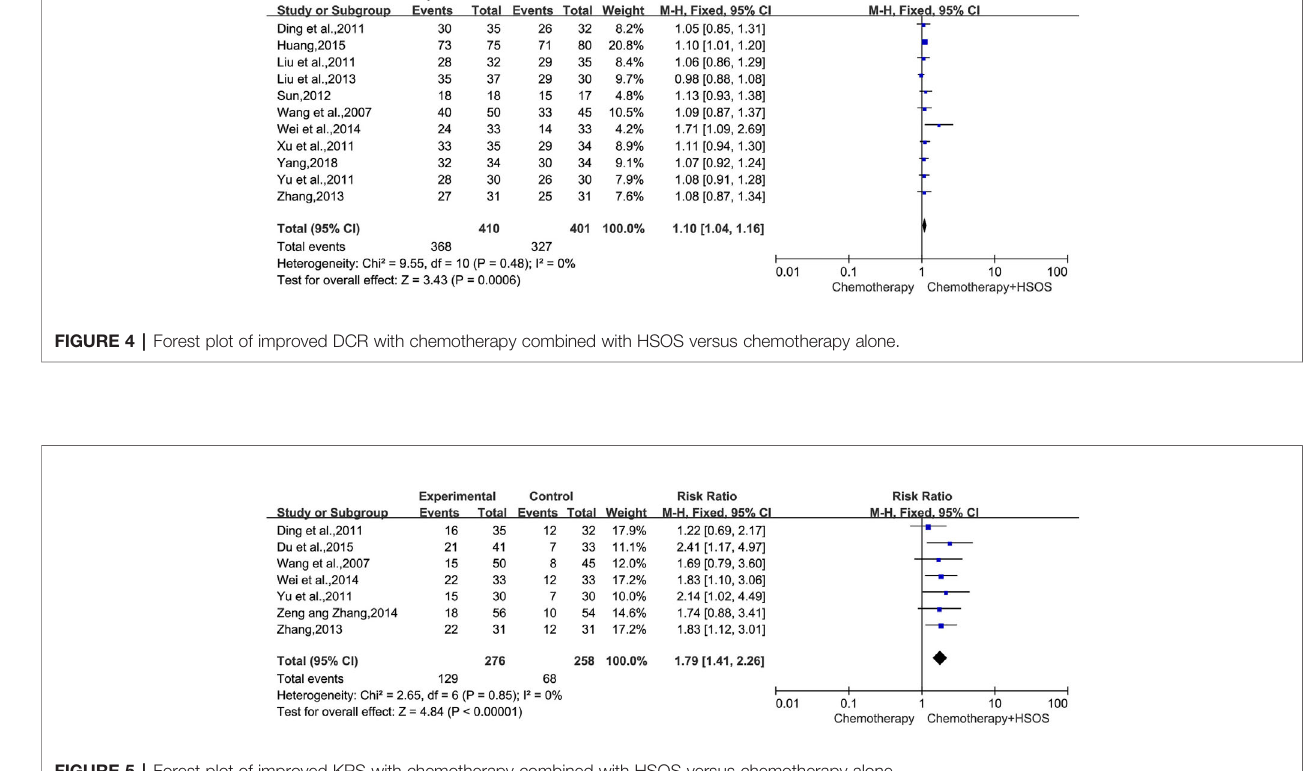
FIGURE 5 | Forest plot of improved KPS with chemotherapy combined with HSOS versus chemotherapy alone.